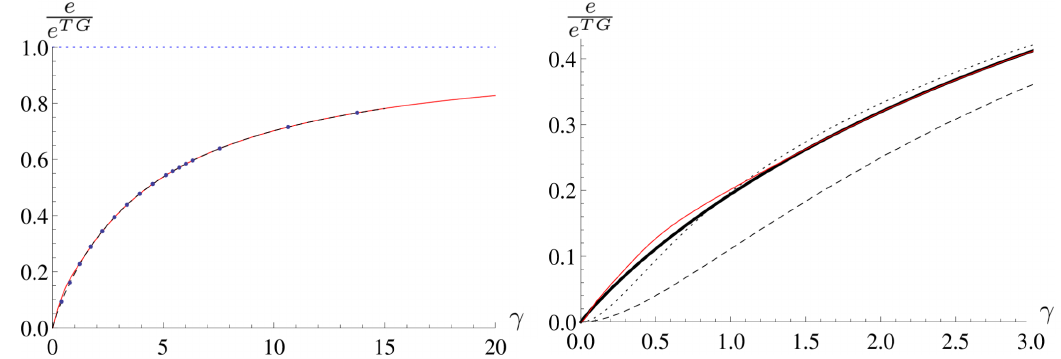
Figure 3: Left panel: dimensionless ground state energy per particle e normalized to its value in the Tonks-Girardeau limit e TG (dotted, blue), as a function of the dimensionless interaction strength γ : conjectural expansion at large γ (solid, red) as given by Eq. (23) to sixth order, small γ expansion (black, dashed) as given by Eq. (10) and numerics (blue points). Right panel: zoom in the weakly-interacting region. Numerically exact result (black, thick) is com- + e pared to e (black, dashed), e (black, dotted) and the sixth-order expansion (red) in 0 0 1 Eq.